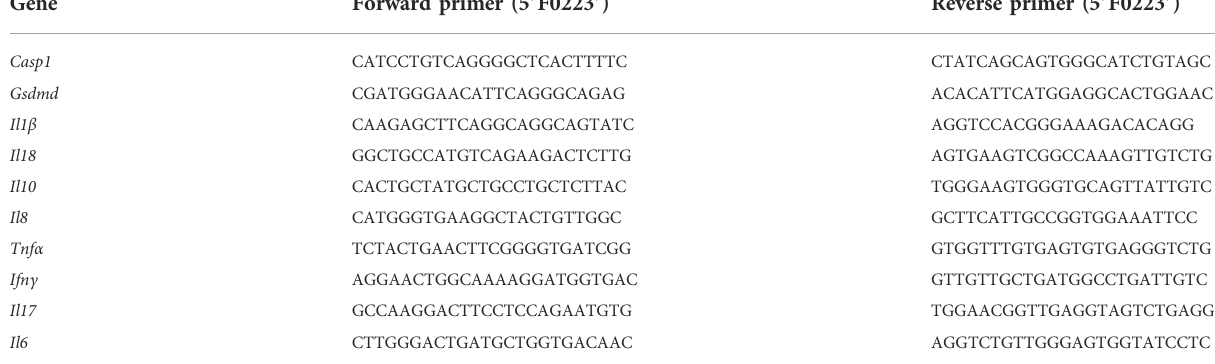
TABLE 1 Primer sequence